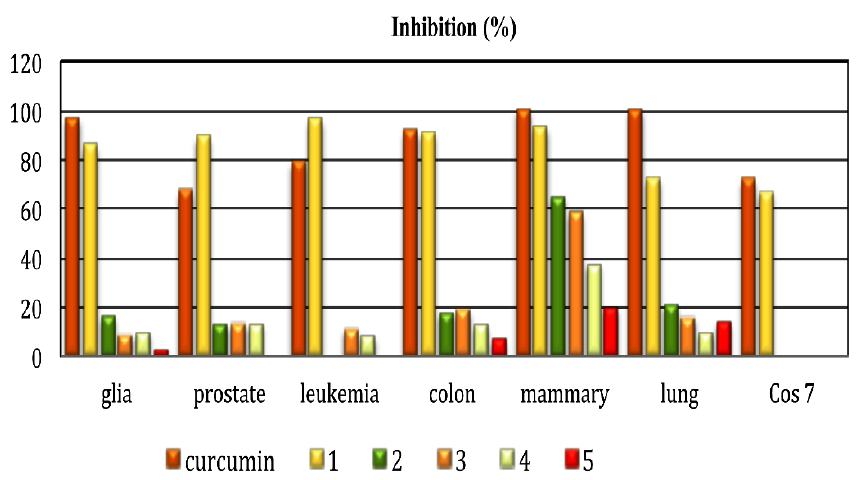
Figure 2. Cytotoxic activity of curcumin derivatives 1 – 5 .